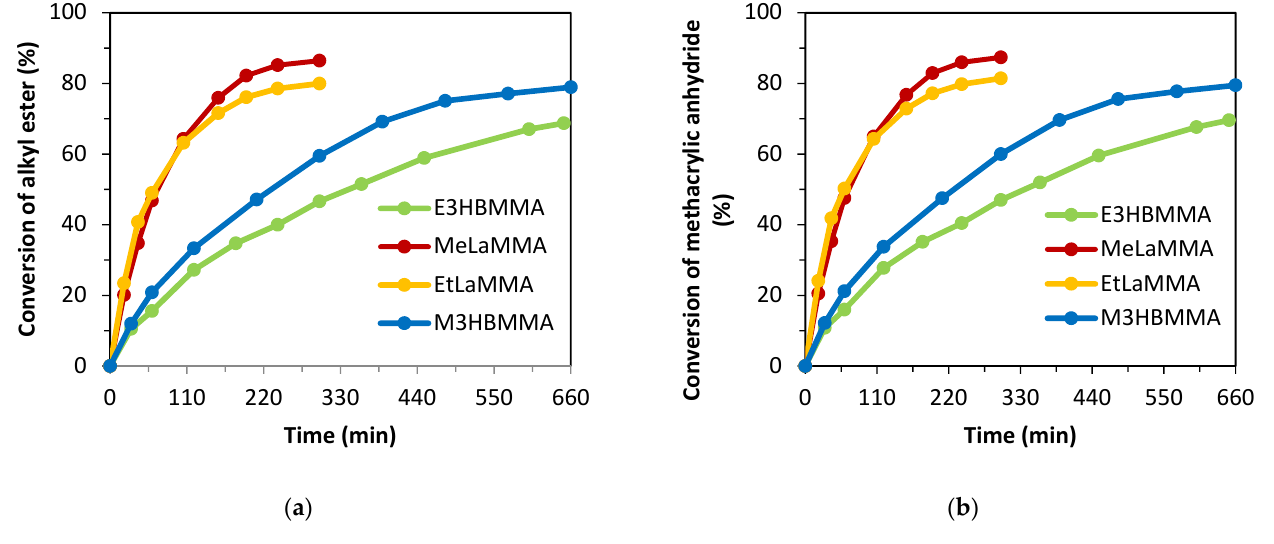
Figure 6. ( a ) The increase in particular conversions of alkyl esters of lactic and 3-hydroxybutanoic acid in time during the methacrylation reactions; ( b ) The increase in conversion of methacrylic anhydride in time during the methacrylation reactions.